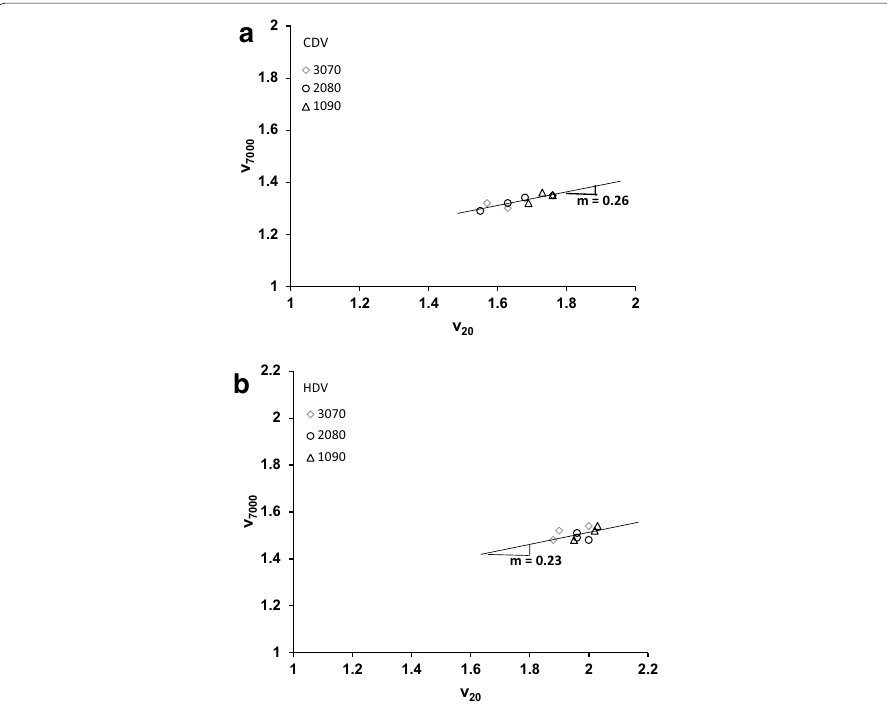
Fig. 8 Combined quantification of convergence: a CDV mixtures and b HDV mixtures